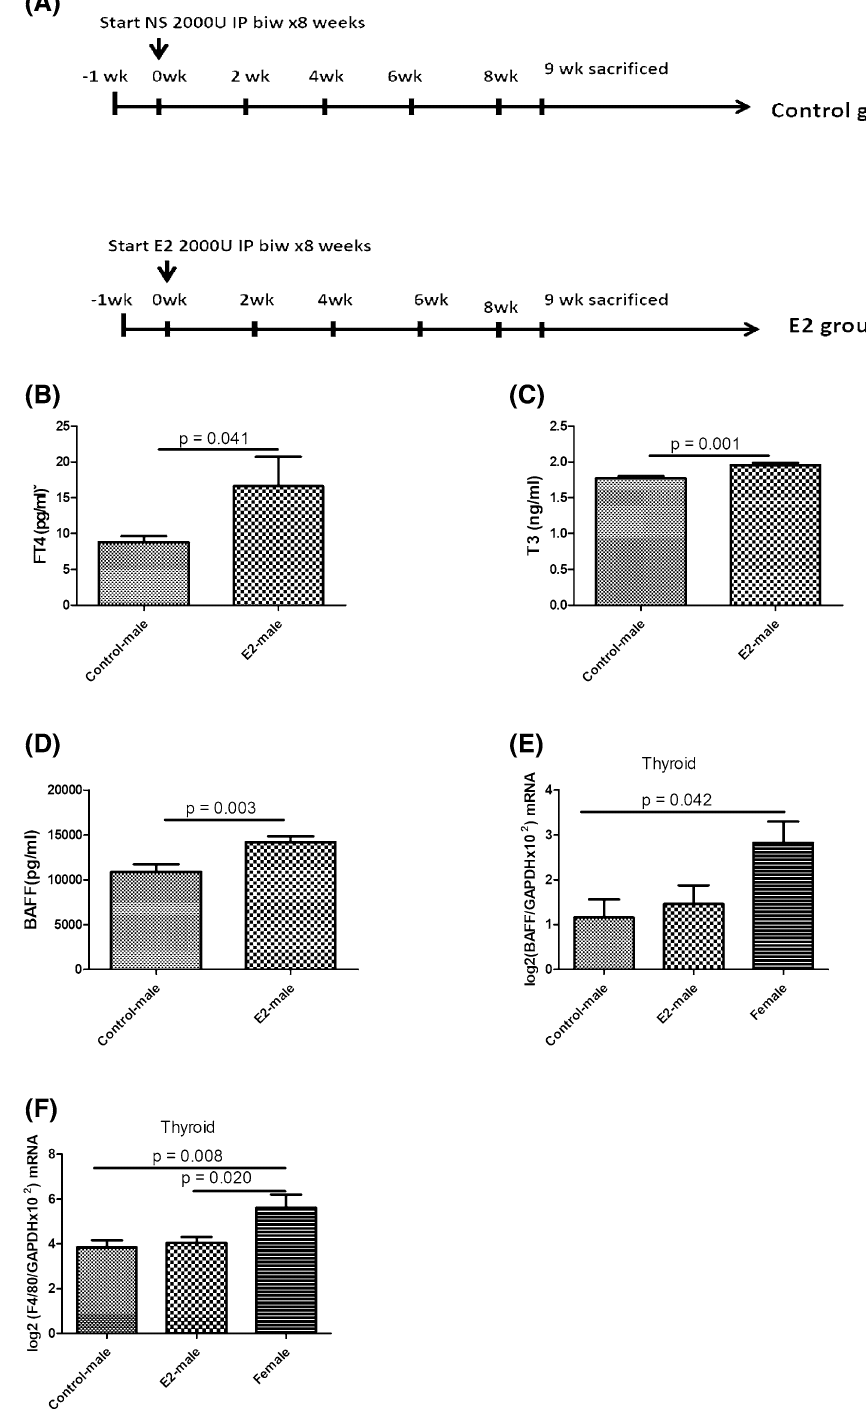
Figure 6. Protocol of estrogen (E2) treatment in NOD.H-2h4 mice ( A ), and ( B ) the free thyroxine (FT4), ( C ) triiodothyronine (T3), and ( D ) B-cell-activating factor (BAFF) protein levels between control-male and E2-treated mice, and ( E ) BAFF , and ( F ) F4/80 mRNA levels among control-male, E2-treated male, and female mouse